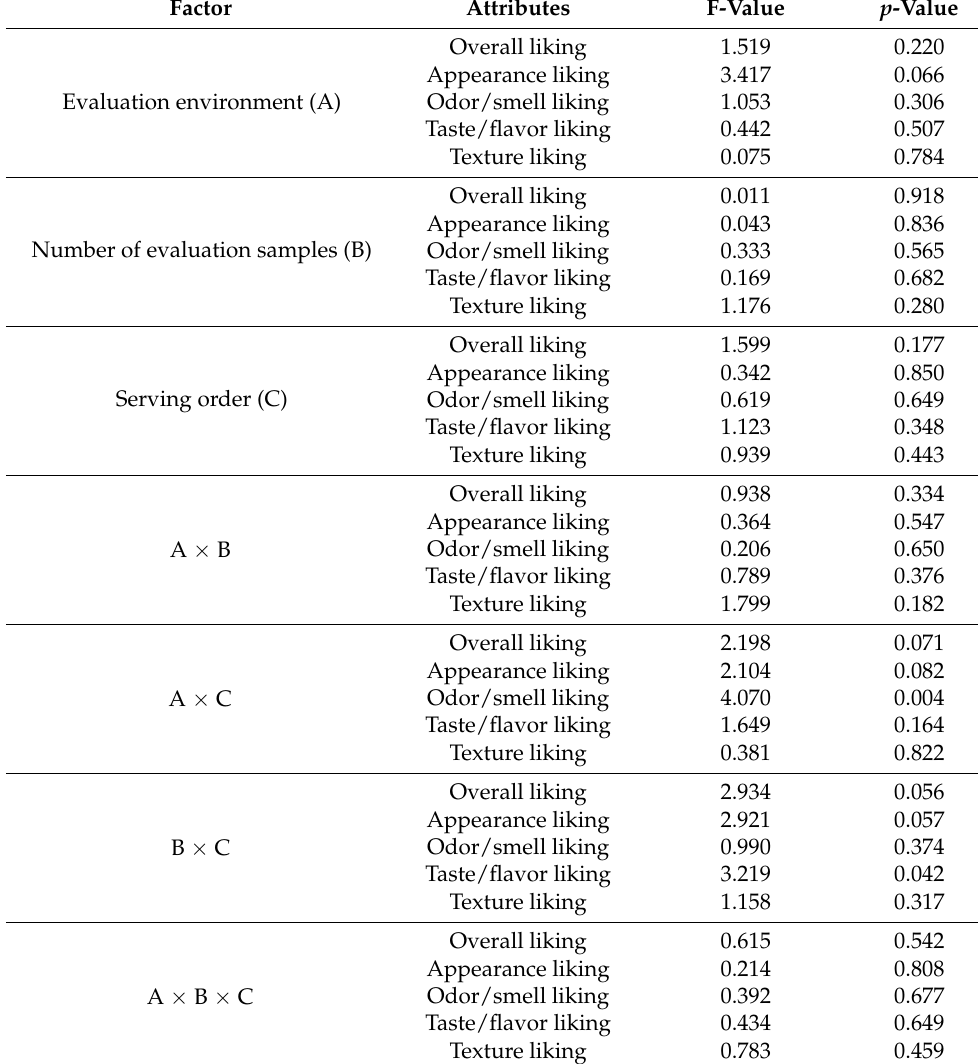
Table 6. Effect of the evaluation environment, the number of evaluation samples, and the serving order on the liking ratings for the three-sample and five-sample conditions of the vegan ramen test target